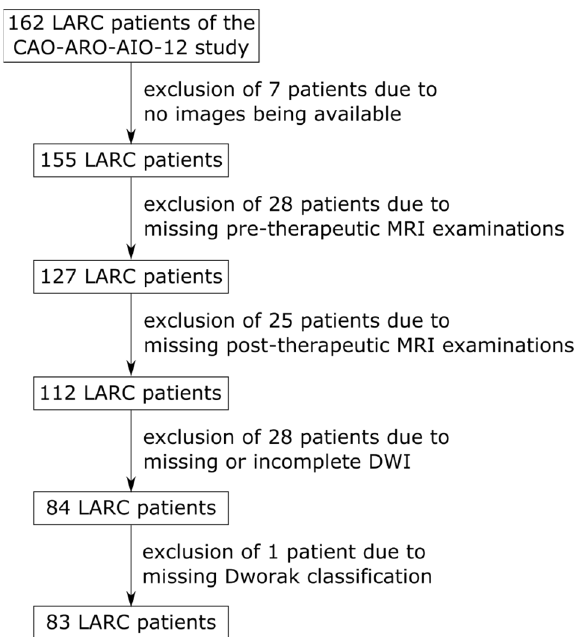
Figure 1. Flowchart of the inclusions and exclusions of LARC patients of the CAO-ARO-AIO-12 study.